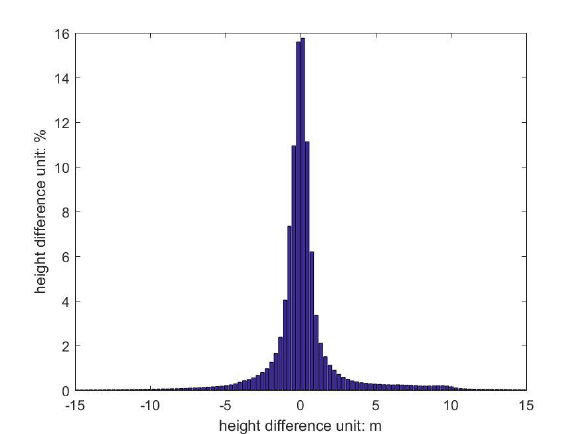
Figure 9. The distribution of the height difference